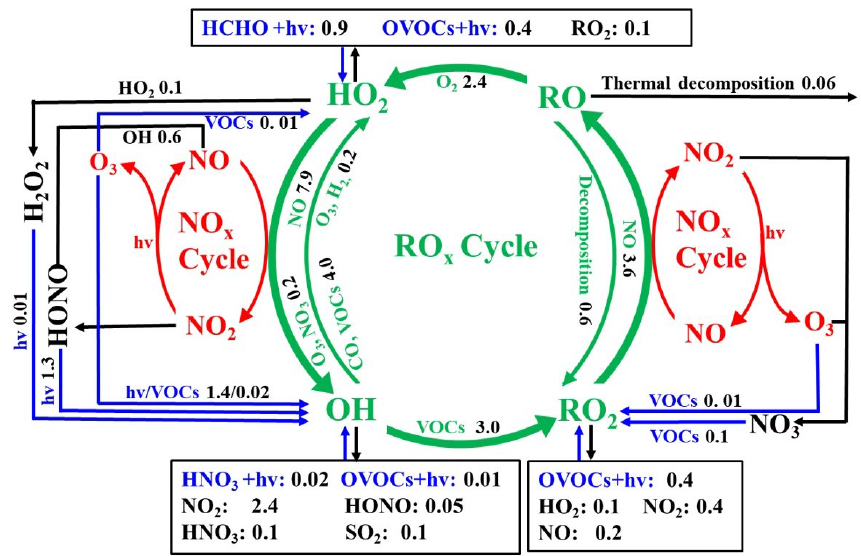
Figure 7. Daytime RO x budget during 20–29 September 2019 in Xiamen. The unit is parts per billion per hour. The blue, black, and green lines and words indicate the production, destruction, and recycling pathways of radicals, respectively.